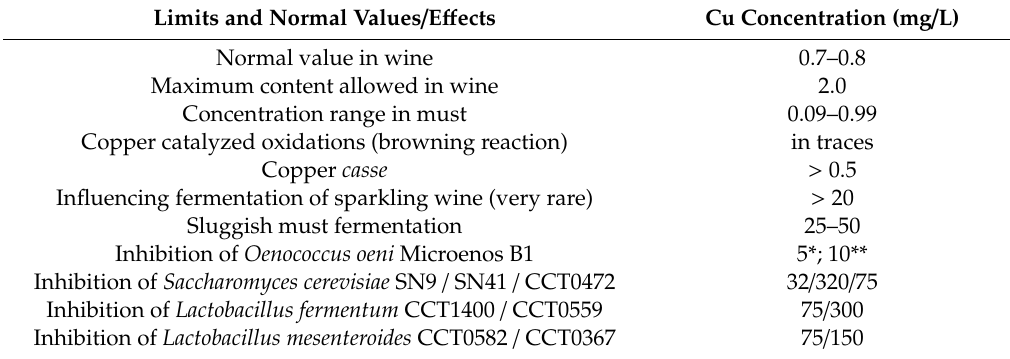
Table 1. Copper concentrations in must and wine with corresponding e ff ects